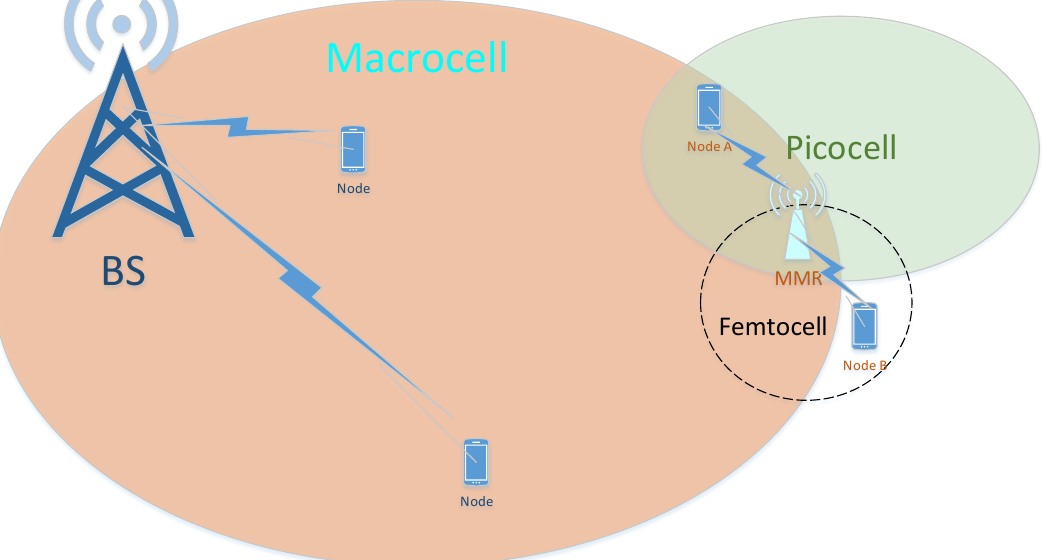
Figure 1. Multi-mode relay (MMR) running in the modes of picocell BS and femtocell